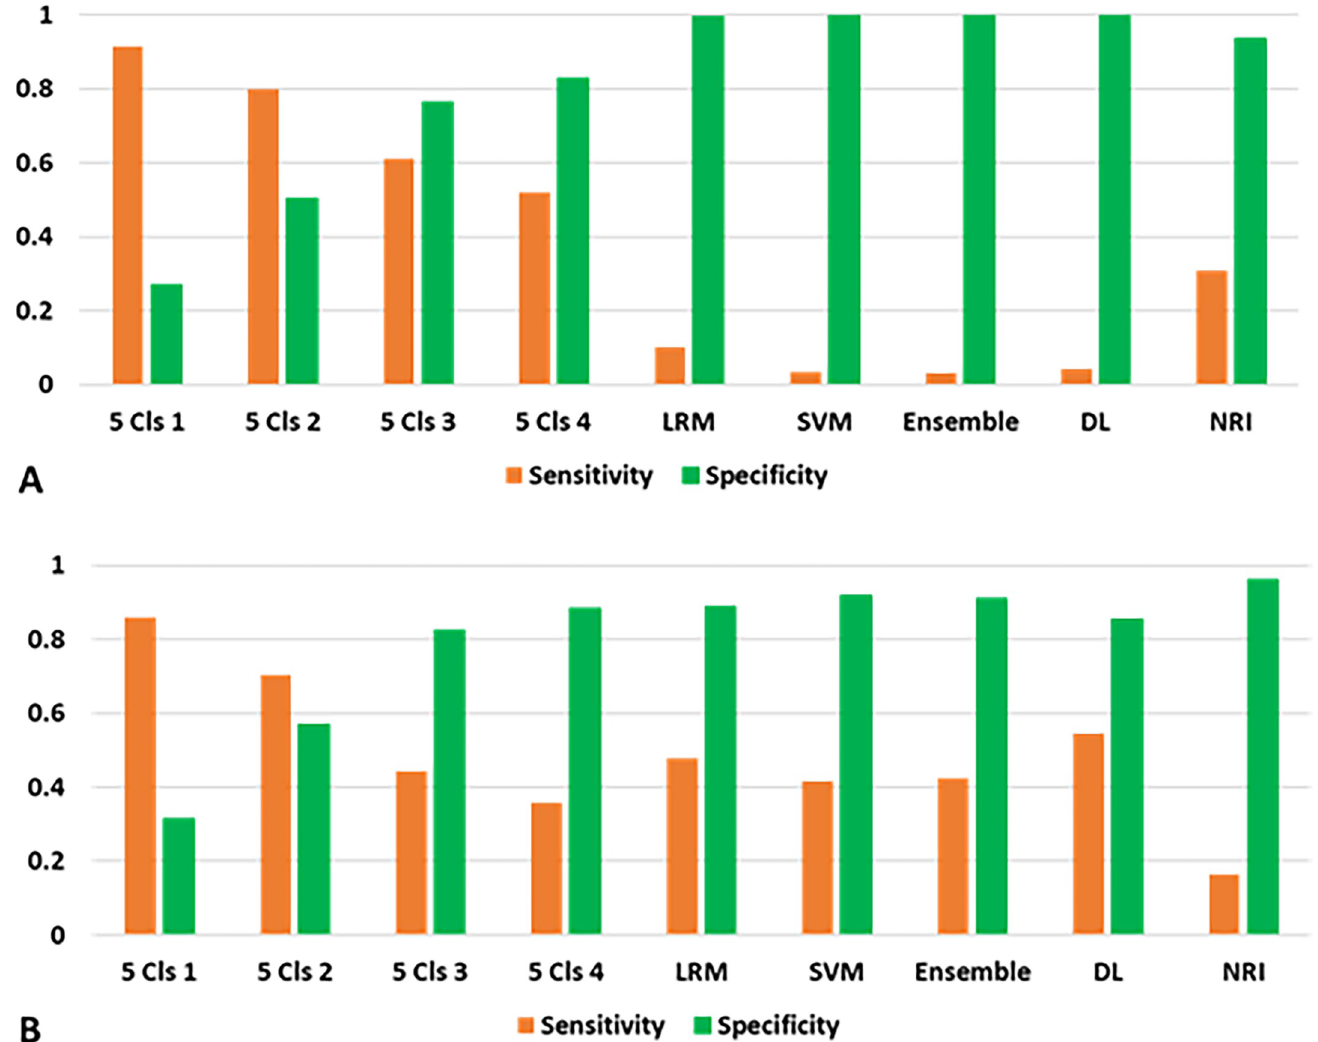
Fig 11. Sensitivities and specificities of models to predict risks of 1-year and 5-year deaths. A. 1-year death. B. 5-year death. Abbreviations: 5 Cls 1, the cutoff point was the first cluster of five clusters; LRM, multivariate logistic regression model; SVM, support vector machine; ensemble, ensemble model of K-means method and SVM models; DL, deep learning model; NRI, nutritional risk